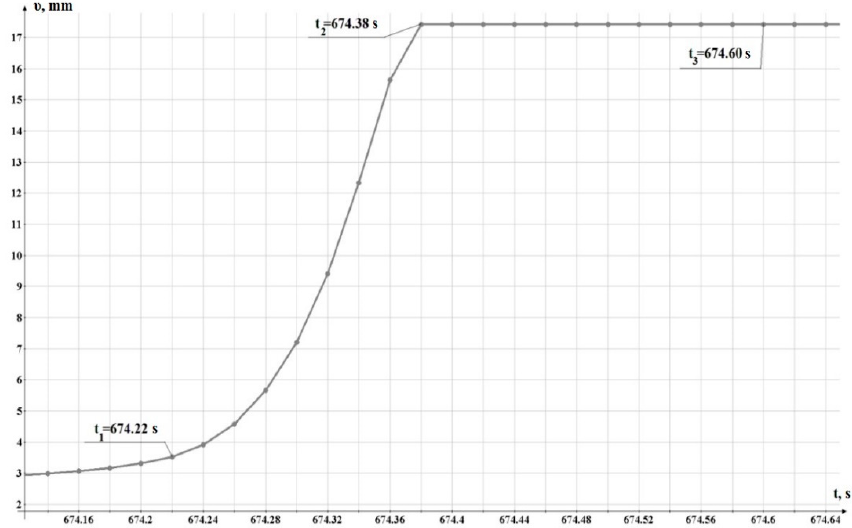
Figure 23. Dependence of deflections, mm ( y -axis) on time, s ( x -axis) in the phase of loss of stability of the upper chord of the truss (P = 4.1 kN). Experiment No. 3.